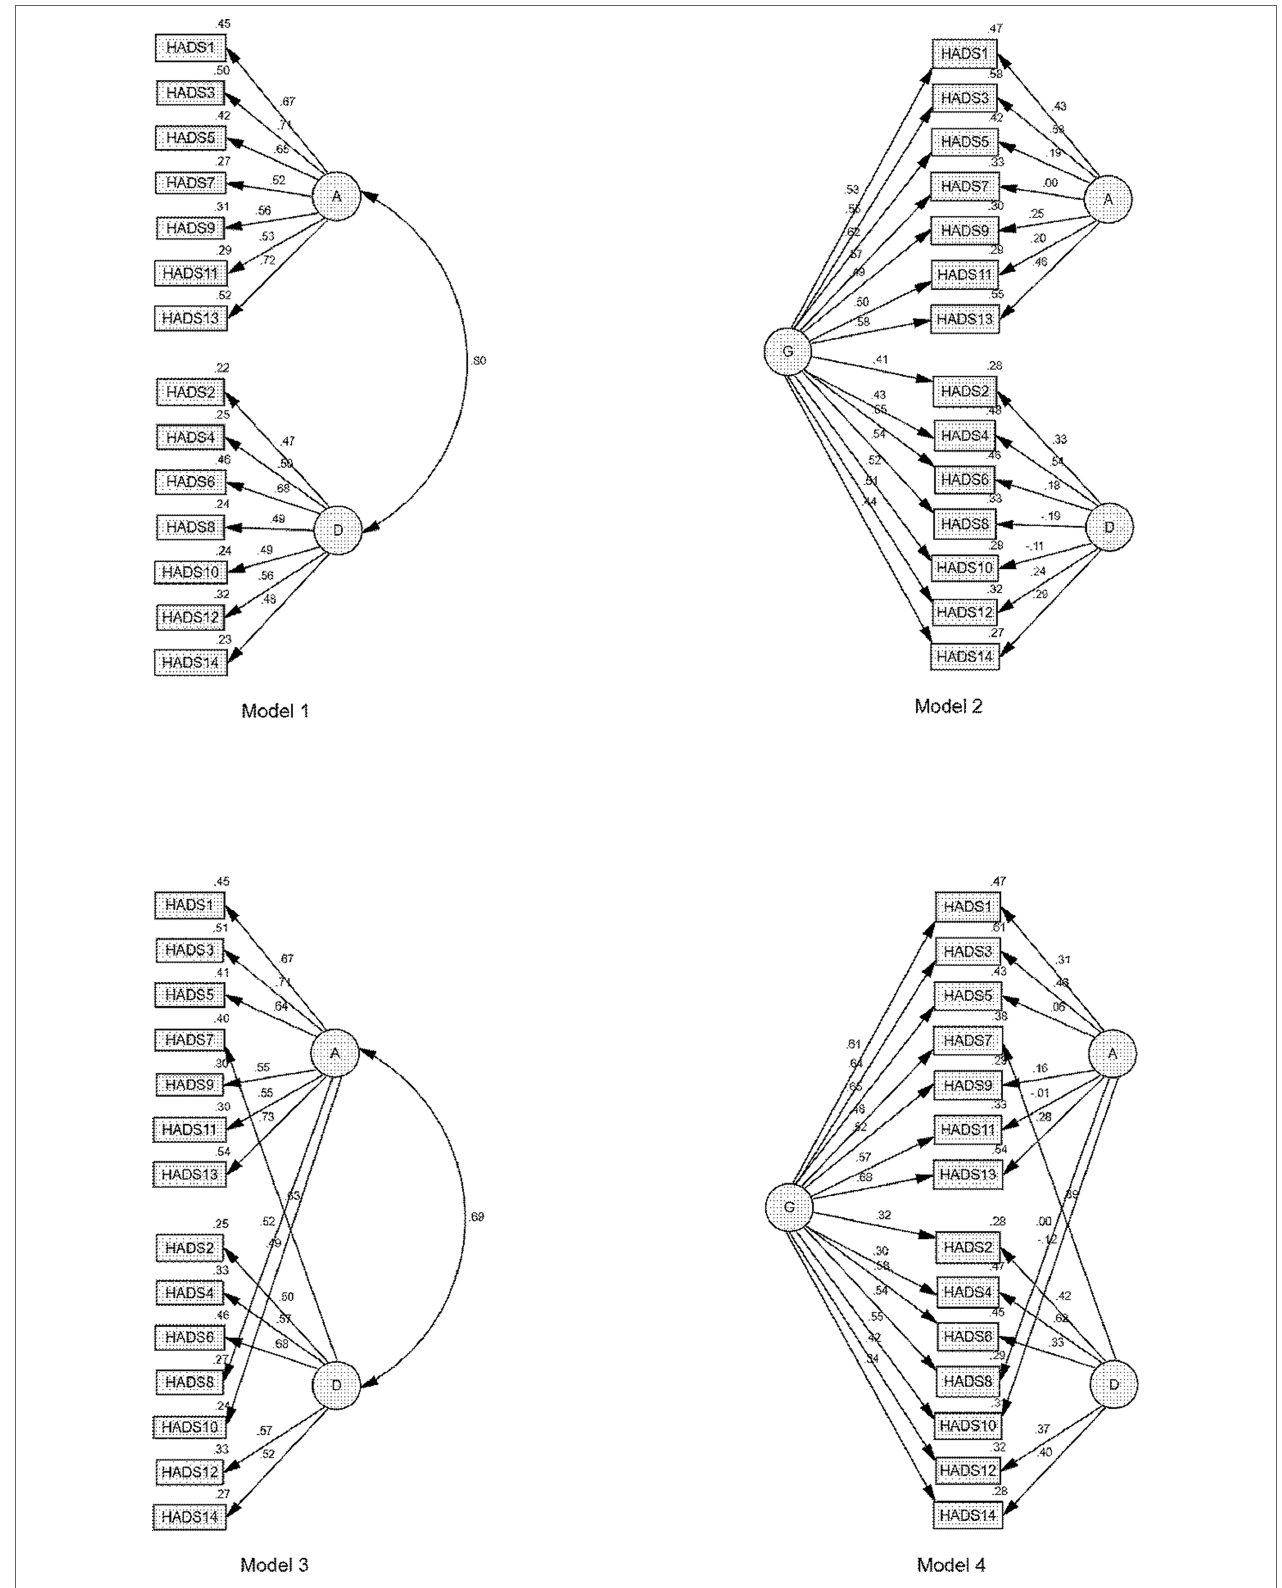
FIGURE 1 | Factor loadings for each tested model. A, anxiety; D, depression; G, general distress. Large ovals represent latent variables; straight lines with arrows represent hypothesized direct effects; rectangles represent measured variables; small ovals represent error terms; and numbers represent standardized parameter